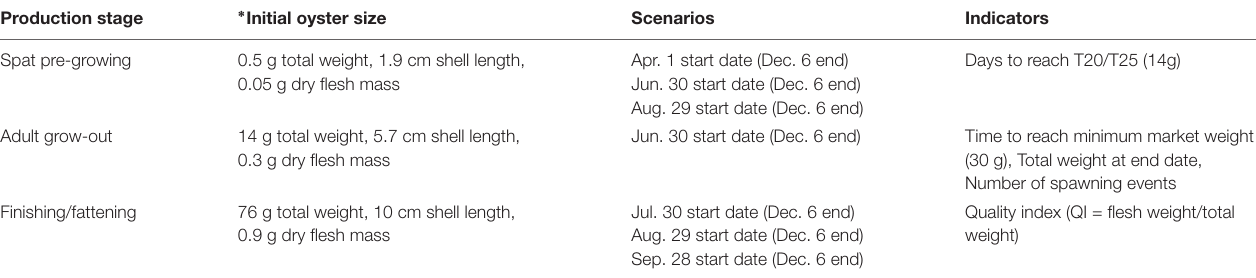
∗ Initial sizes correspond to commercial ratings of T6–T8 for spat pre-growing, T20–T25 for adult grow-out, and Caliber 3 for